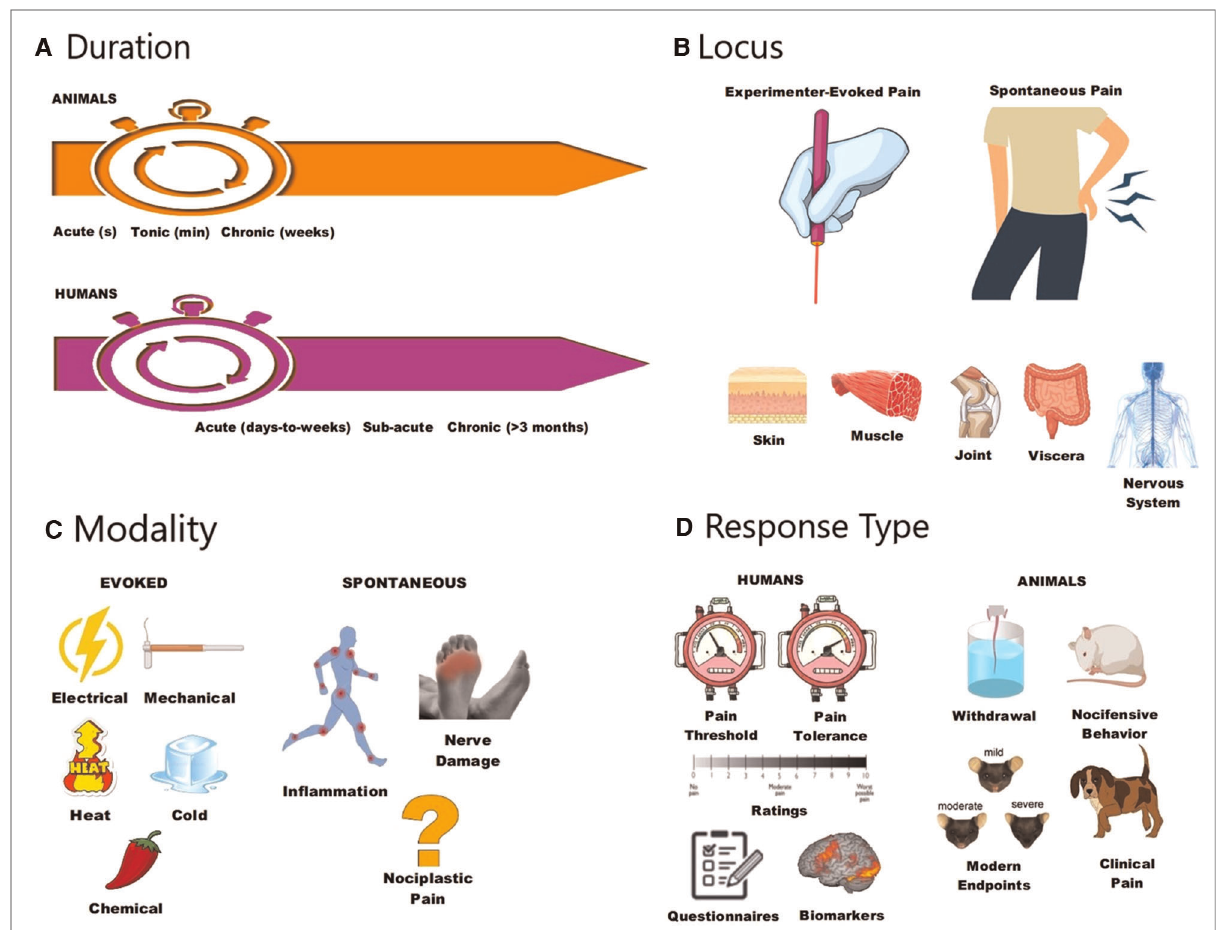
FIGURE 1 Different ways to think about different types of pain, all with implications for algesiometry in humans and non-human animals. Pain can be dissociated based on its duration ( A ), locus ( B ), modality ( C ), and response type ( D